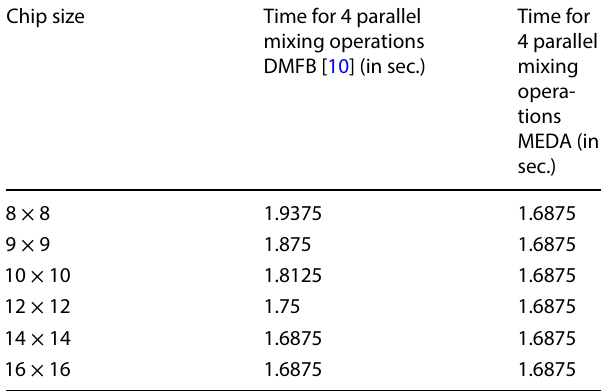
Table 8 Mixing completion for 1 st layer of PCR using various chip- size Chip size